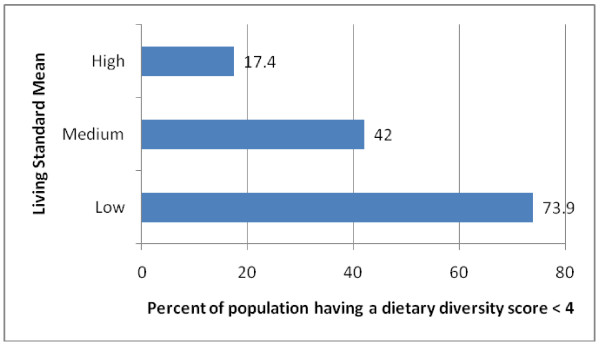
Percent of the population (with 95th CI) having a dietary diversity score less than 4 according to living standards.